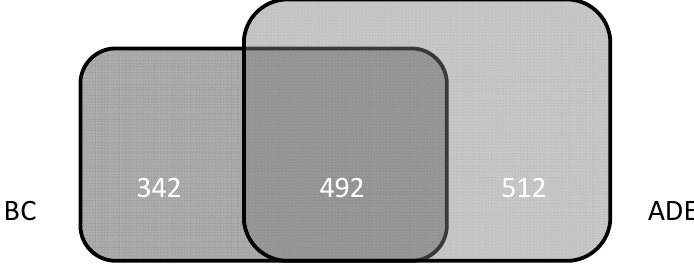
Figure 4. Venn diagram of the operational taxonomic units (OTUs) based on the 16S rRNA gene analyzed by pyrosequencing (454 Roche). The diagram shows OTUs found exclusively in ADE (512), in black carbon (BC, 342) and the OTUs in held in common